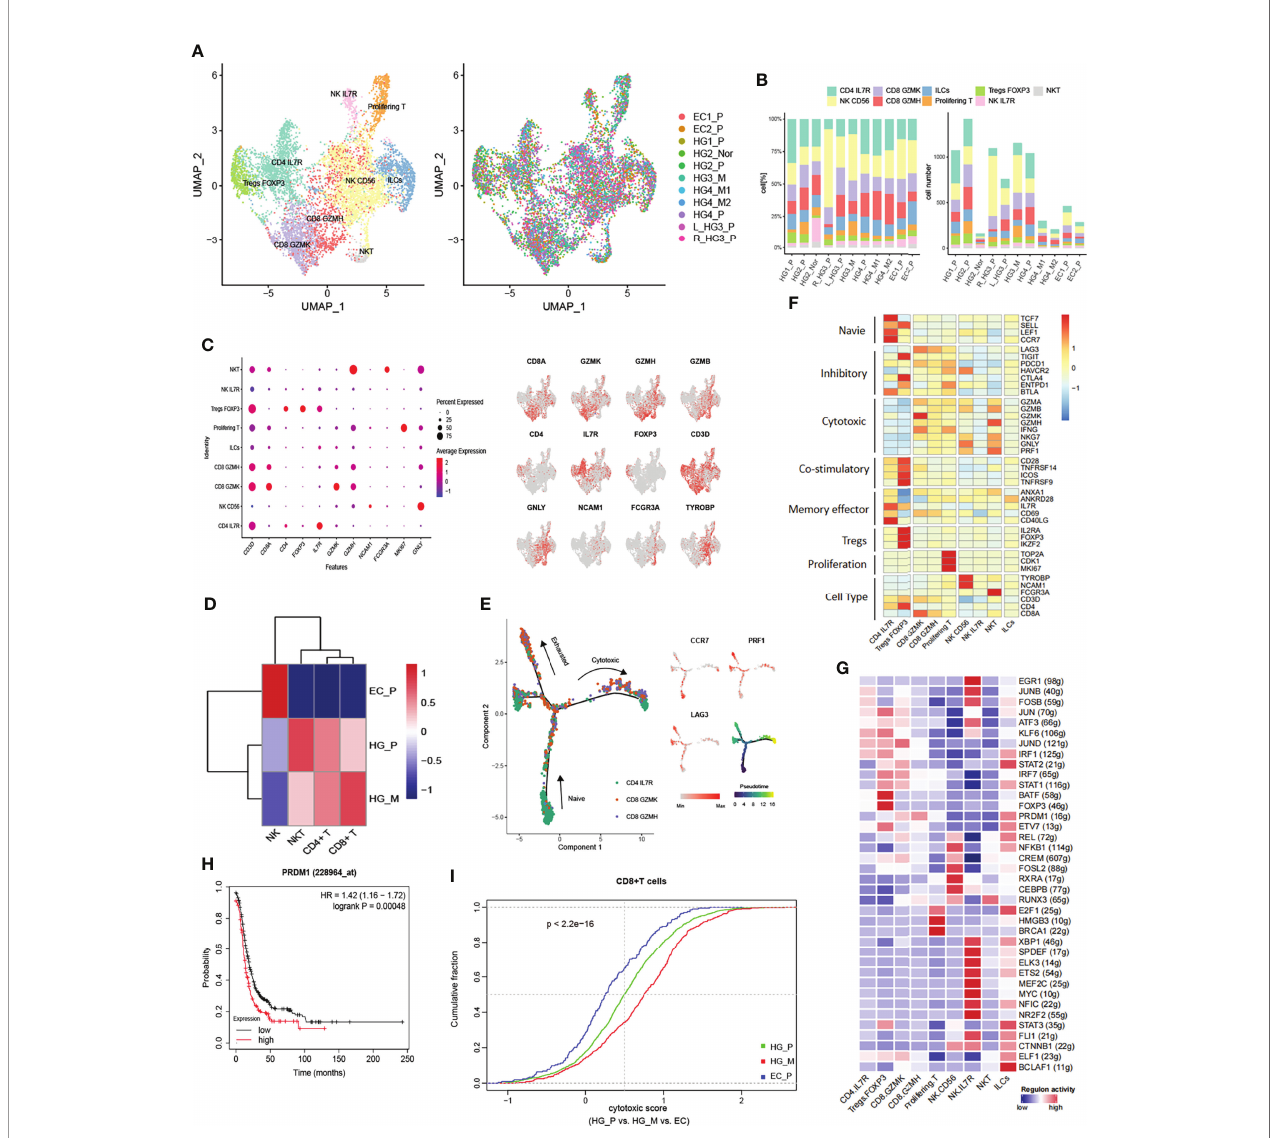
FIGURE 5 | Subpopulations of tumor-in fi ltrating lymphocytes (TILs) in HG_M. (A) The UMAP projection of 7967 TILs of 11 samples from six patients (indicated by labels and colors). (B) Proportion and cell number of each subtype in 11 samples. (C) Dot plot (left) and UMAP-plot (right) display canonical cell markers. (D) Hierarchical clustering heatmap groups the tumors between HG_P, HG_M, and EC_P. (E) Reconstruction trajectory of CD8 + T cells inferred by Monocle2 (color by subtypes, expression of signature genes, and pseudotime). (F) Heatmap of the functional gene sets in TILs. (G) Active Regulons in each TILs. (H) Overexpression of the PRDM1 gene predicts a worse prognosis in ovarian cancer. (I) Cumulative distribution of cytotoxic CD8 + T cells between HG_P, HG_M, and EC_P. The cytotoxic score is calculated based on the average expression of cytotoxic markers. P-value was calculated by a two-sided unpaired Kruskal-Wallis rank-sum